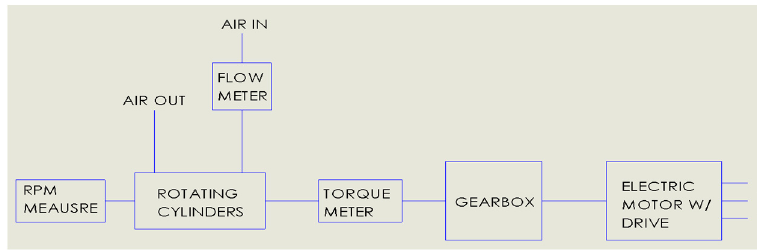
Figure 5. Experimental procedure flow diagram.